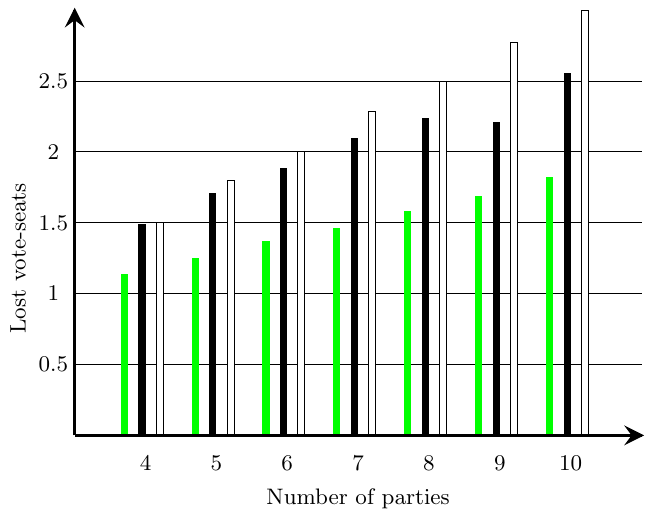
Figure 2: Average number of vote-seats versus the number of parties. The grey bar represents the average number of vote-seats and the black bar the maximum number of lost votes found for the 6 000 simulation runs. The white bar gives the theoretical maximum that follows from Theorem